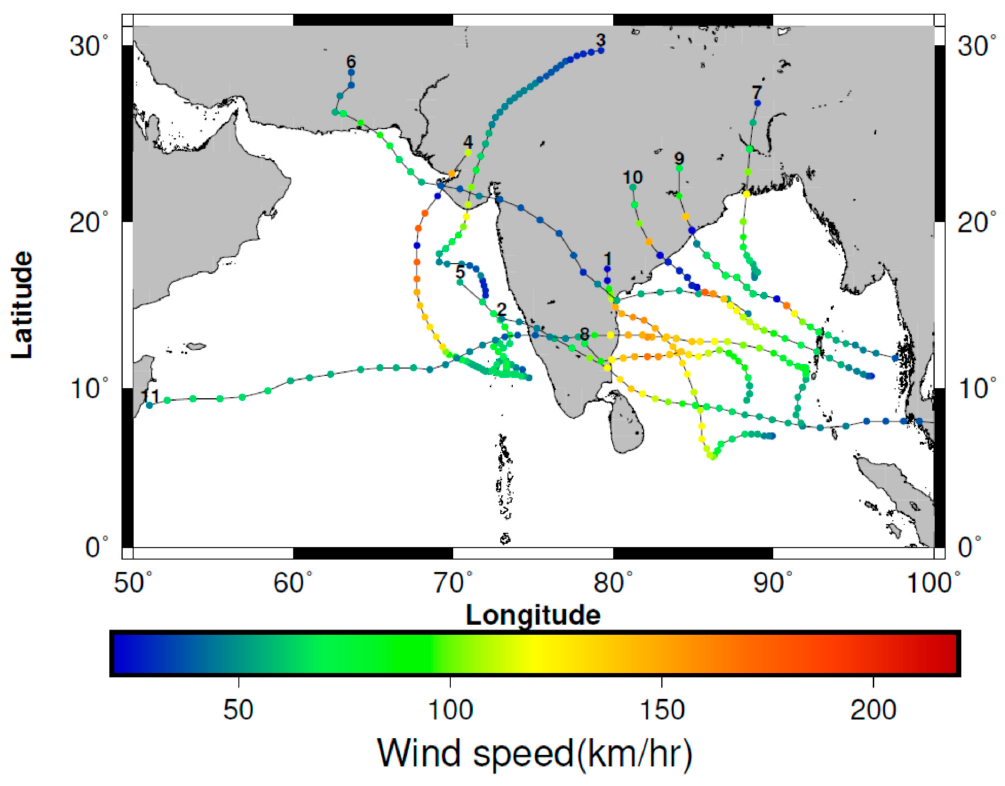
Figure 12. Tropical cyclone tracks corresponding to the maximum wave power occurrence at different locations. Table 3. Details of the tropical cyclones represented in Figure 12. The list is as per the chronological order.